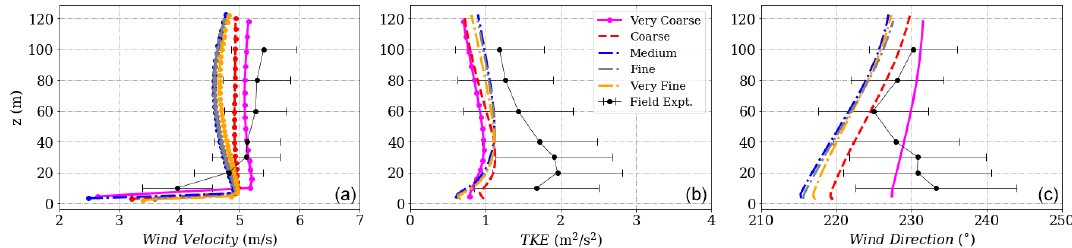
Figure A3. (a) Wind velocity magnitude, (b) wind direction and (c) turbulent kinetic energy at Tower 29 (tse13).